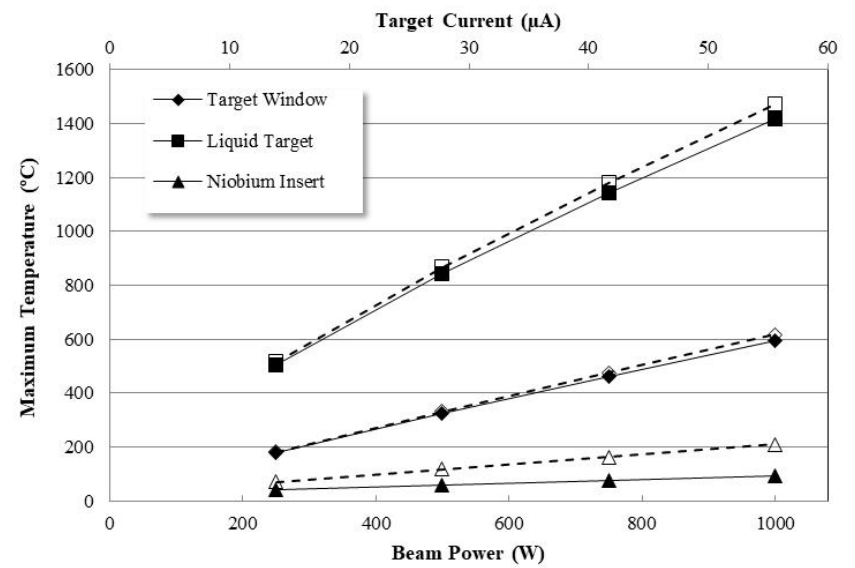
Figure 12. Maximum temperature of the target window, liquid target, and niobium insert, as a function of the beam power (and corresponding target current), for two flow rates of the cooling water of 1 (open symbols) and 3 L/min (full symbols).